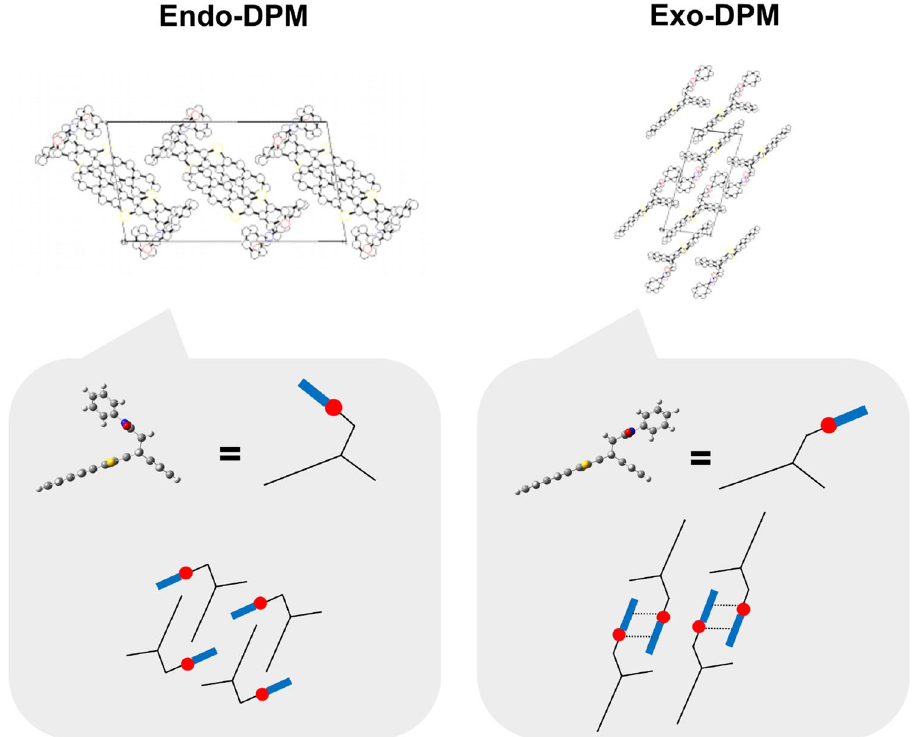
Figure 6. Schematics of the known crystal structures of endo-DPM and exo-DPM. Top schematic reprinted with permission from the following article: Kimura et al. 10 , Figs. S5 and S7 (2015). ( Copyright 2014 WILEY– VCH Verlag GmbH & Co.